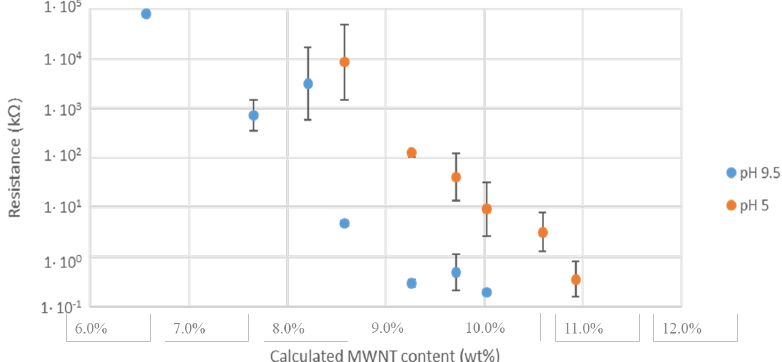
Figure 9. The electrical resistance of composites made from PS 26 PAA 580 polymer. Increasing the wt% of MWCNTs results in reduced resistance. For every sample an acidic (pH 5) and alkaline (pH 9.5) composite was